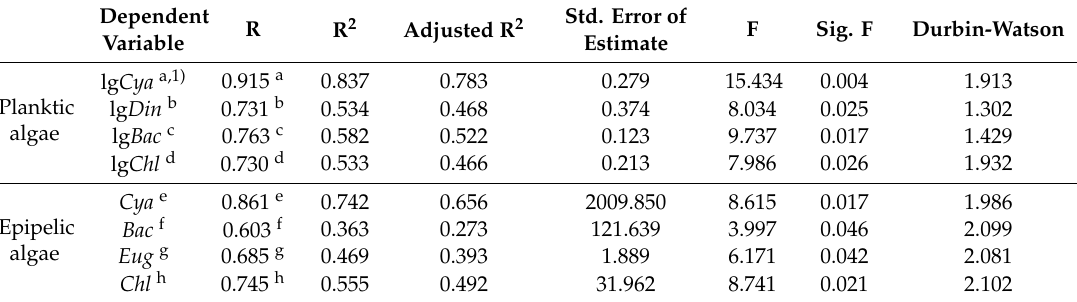
Table 5. Model summary ( n = 9).